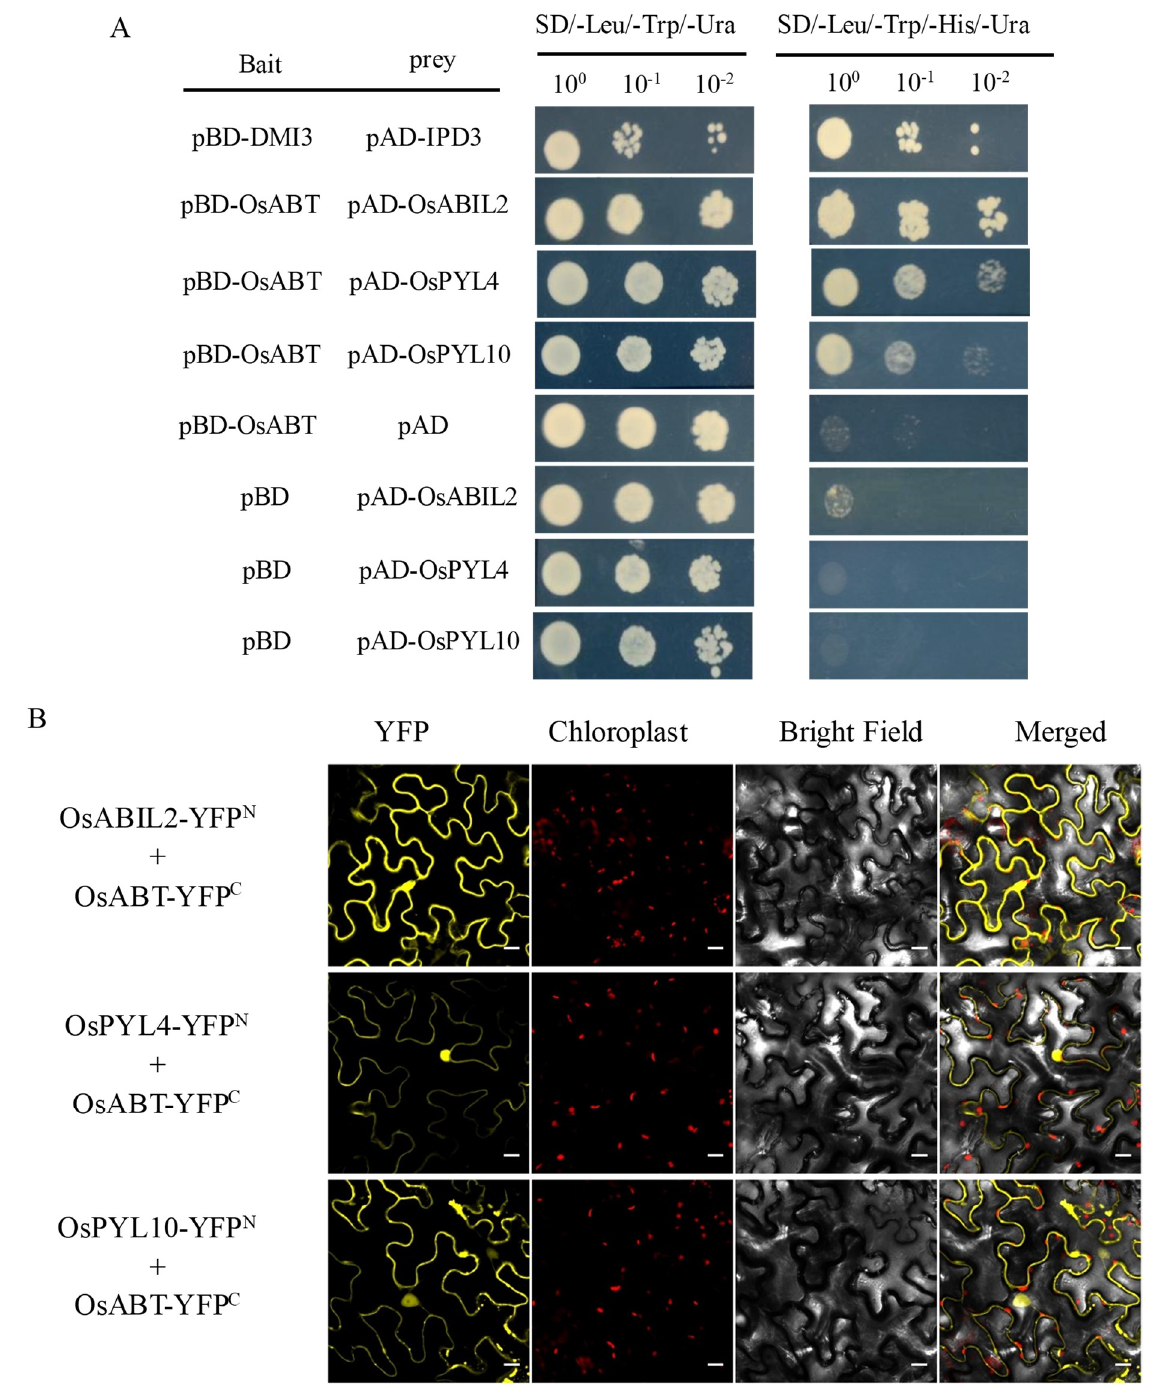
Figure 5. OsABT interacts with key factors of the ABA signaling pathway. ( A ) Yeast two hybrid (Y2H) assay of the interactions between OsABT and the three ABA signaling proteins OsABIL2, OsPYL4, and OsPYL10. GAL4 binding domain (BD) and GAL4 activation domain were co–transformed into yeast YRG2, and a series of 2 µ L aliquots of the diluted (OD600 = 1, 0.1, 0.01) co–transformed YRG2 culture was spotted on SD/ − Leu/ − Trp/ − Ura and SD/ − Leu/ − Trp/ − His/ − Ura media and incubated for 4 days. ( B ) Bimolecular fluorescence complementation (BiFC) assay of the interactions between OsABT and OsABIL2, OsPYL4, OsPYL10 in Nicotiana benthamiana leaves. Scale bars: 50 μ m.